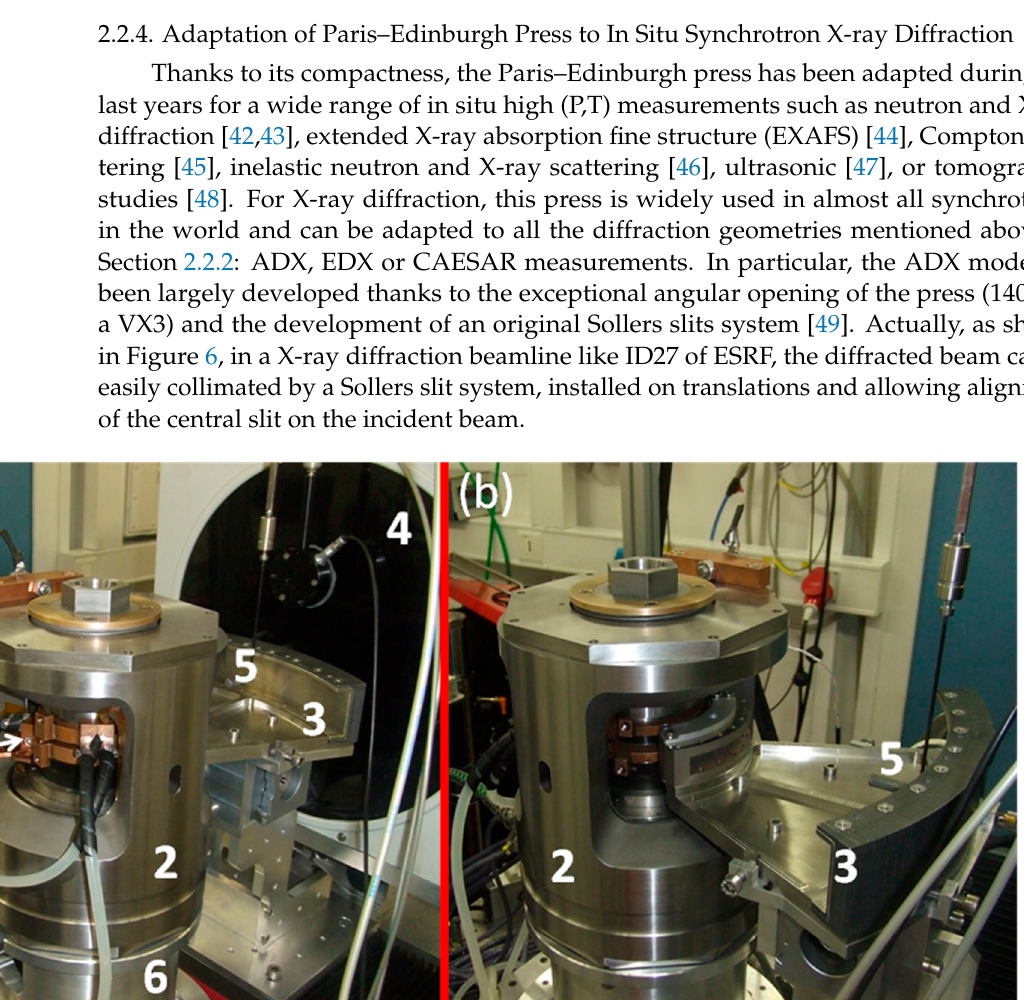
Figure 5. Schematic diagram of two-opposed anvils ( a ) and sample assembly ( b ) of the large volume Paris–Edinburgh press for in situ X-ray diffraction studies (here for ED = 10 mm and FS = 3.5 mm). (1) Cooling device. (2) Steel binding ring. (3) Tungsten carbide WC anvils. (4) Molybdenum disk. (5) Amorphous boron epoxy gasket (pressure medium). (6) Coaxial thermocouple. (7) Graphite heater. (8) Insulating ceramic. (9) Electrical contacts. (10) Graphite disk. (11) h-BN or MgO capsule. (12) Sample.